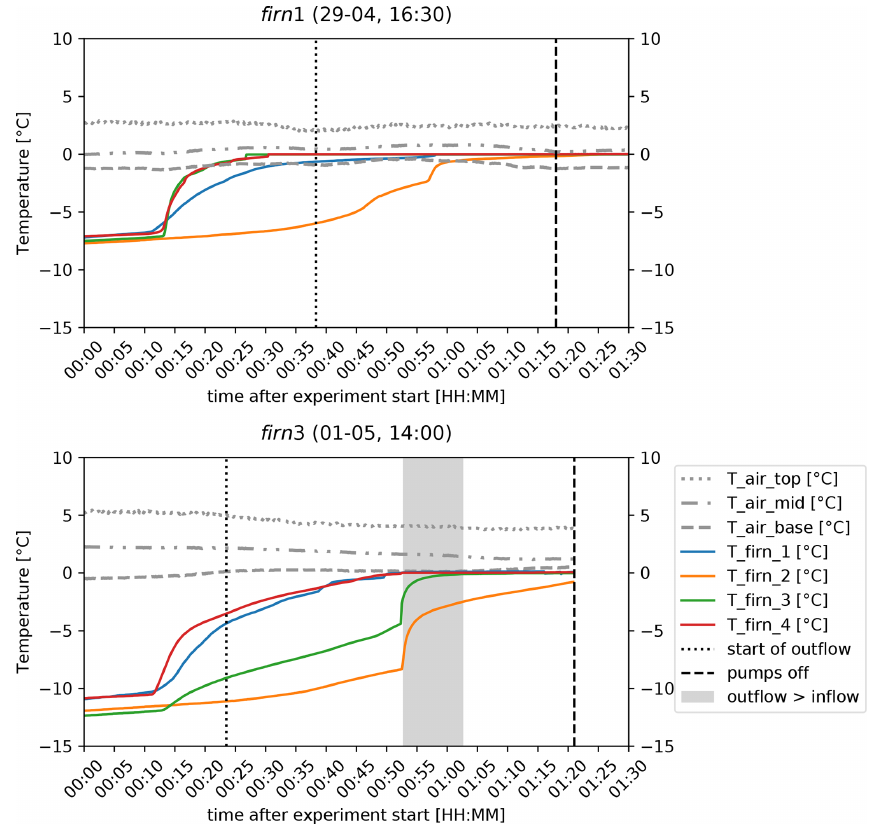
Figure 6. Air and firn temperature over time for experiments firn1 and firn3 . The dashed blue line indicates start time of continuous outflow, and the grey shading shows where outflow > inflow. The dashed black line shows the time at which the experiment was stopped (when pumps were turned off). Coloured lines show temperature evolution at four locations within the firn block, ∼ 1cm above its base. Grey dashed and dotted lines represent air temperatures at the side of